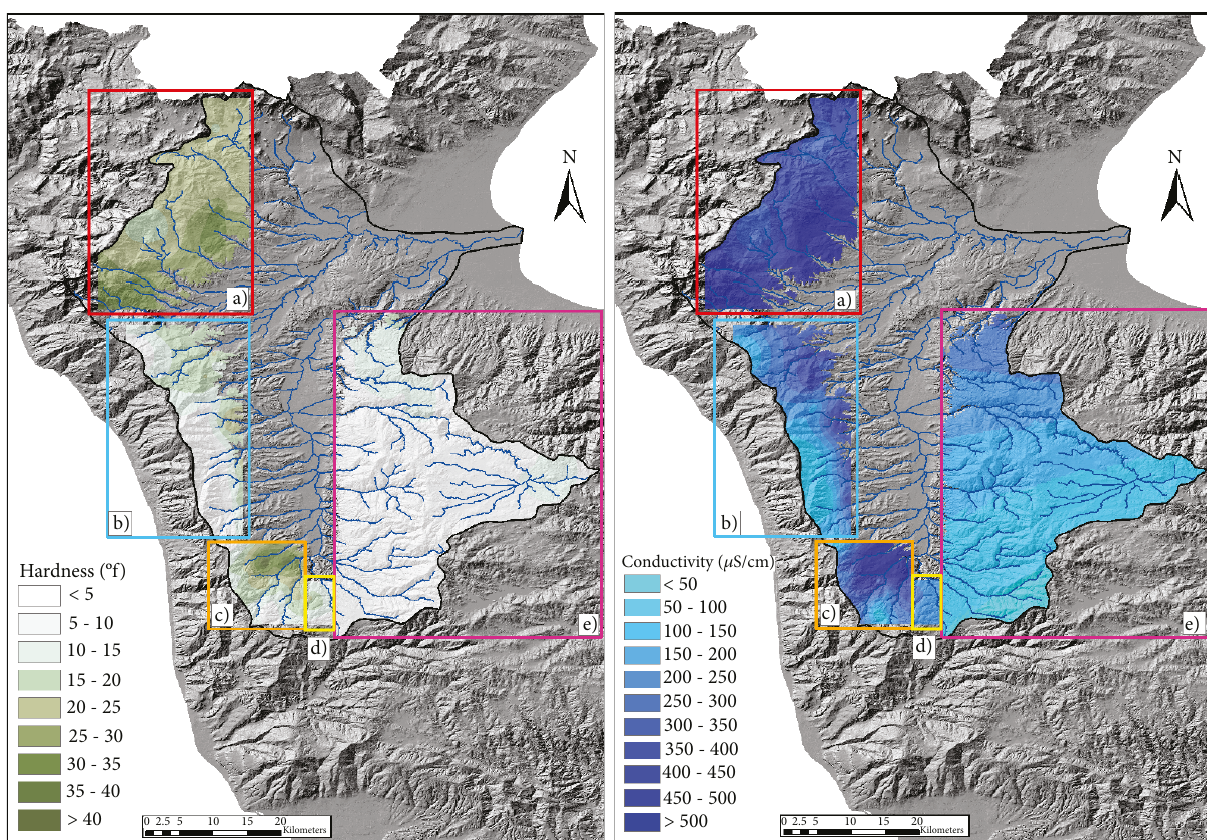
Figure 8: Spatial distribution of hardness and conductivity in waters from the 5 subareas of the Crati river